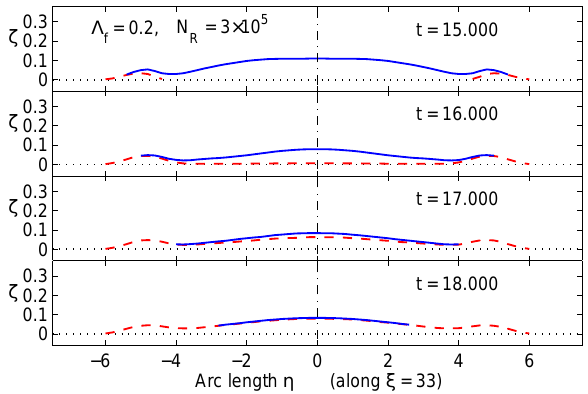
Fig. 8. Cross-sectional view of the flowing mass and evolution of the deposition heap along η at ξ = 33 . 0. The black dotted lines at ζ = 0 represent the basal surface of the chute, the red lines indicate the interface of the deforming deposition heap, and the blue solid lines mark the free surface of the flowing layer.